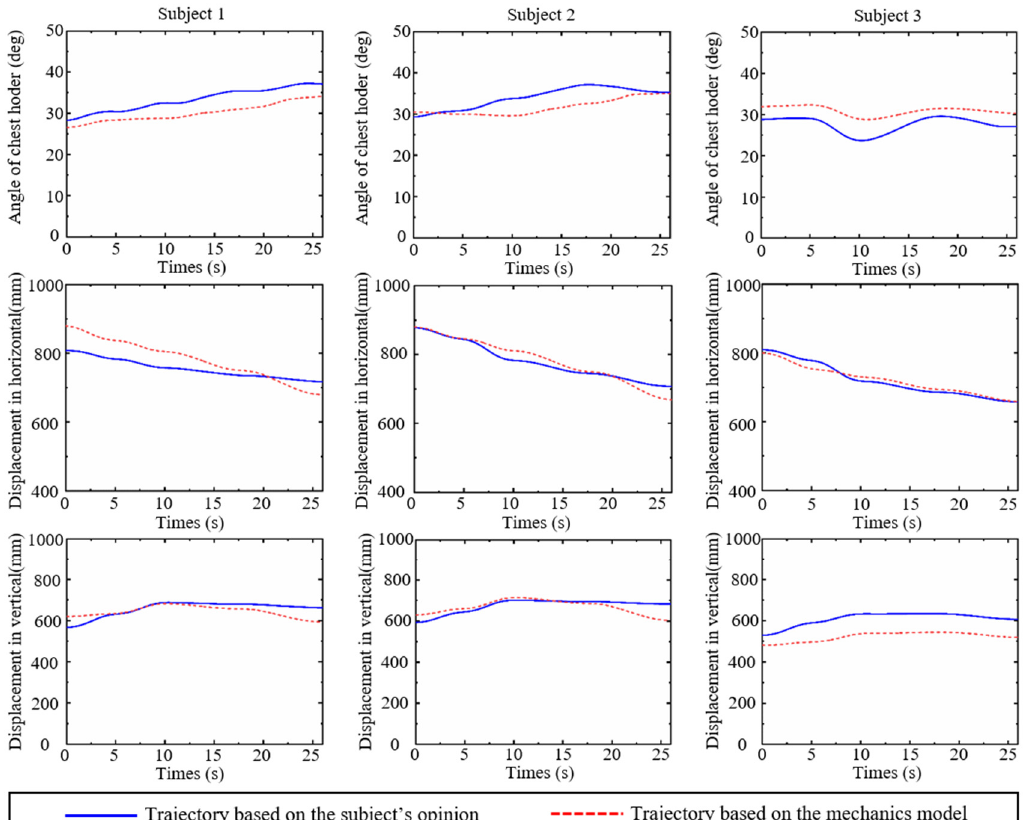
Figure 8. The posture of the chest holder in different motions.